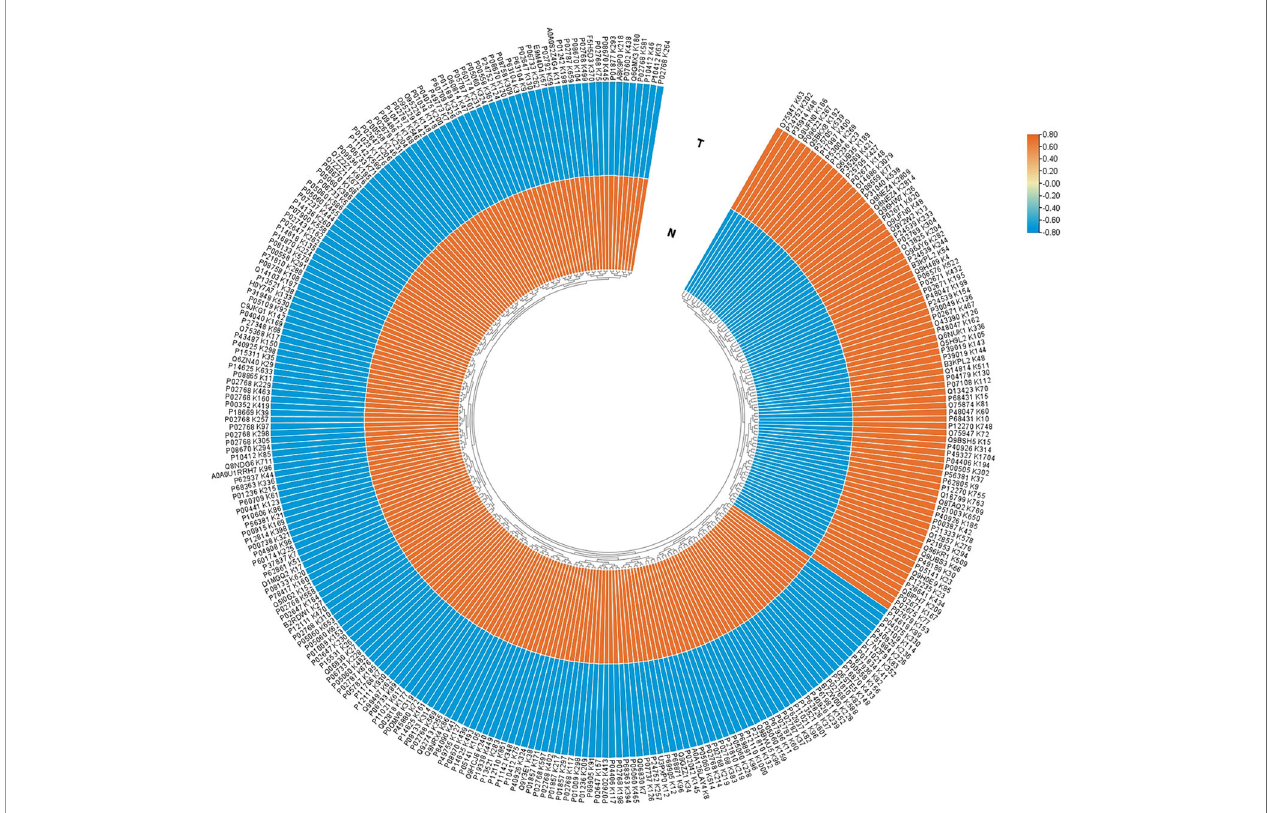
FIGURE 3 | Acetylation quanti fi cation heatmap of differentially acetylated lysine sites at proteins in NF-PitNETs and control tissues. “ K ” means the lysine site. The protein name is able to be got according to the accession number. Orange means increased acetylated level, and blue means decreased acetylated